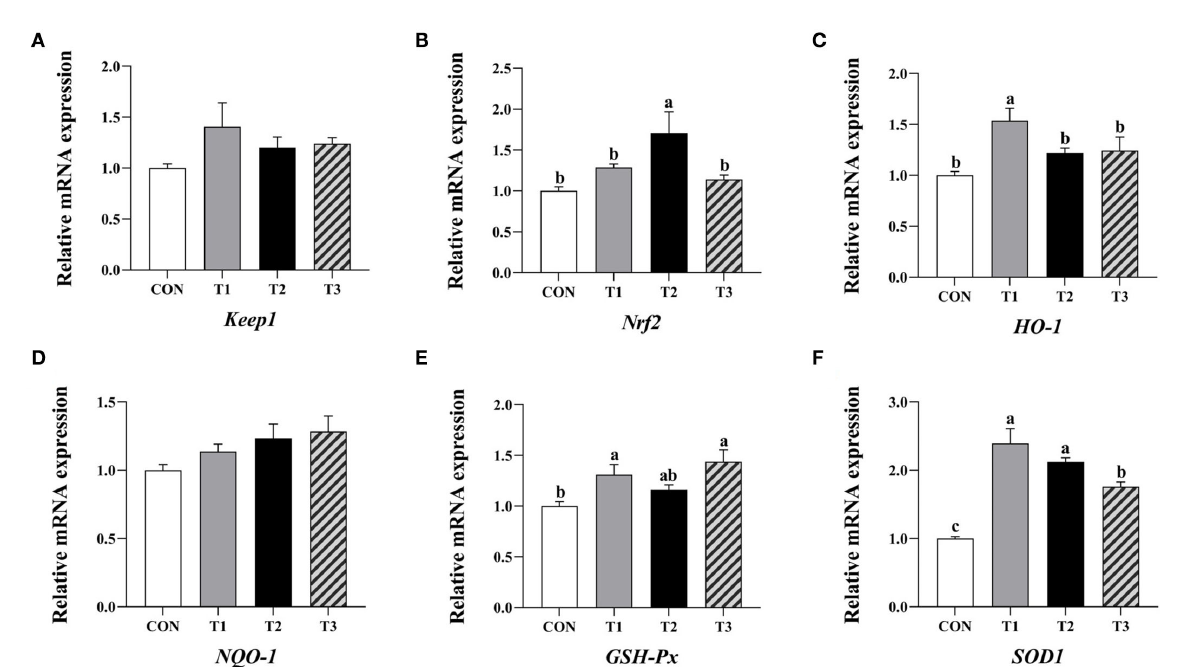
FIGURE2 Effect of quercetagetin on expression level of antioxidant related genes in inileal mucosa of broilers. Values are means ± standard deviation ( n = 10). Above the bar no letter or the same letter mean no significant ( P > 0.05), while with different letter mean significant difference ( P < 0.05). Kelch-like ECH-associated protein 1 (Keap1) (A) , Nuclear factor E2 related factor 2 (Nrf2) (B) , Heme oxygenase-1 (HO-1) (C) , NAD(P)H: quinone oxidoreductase 1 (NQO-1) (D) , Glutathione peroxidase (GSH-Px) (E) , Superoxide dismutase 1 (SOD1) (F) .